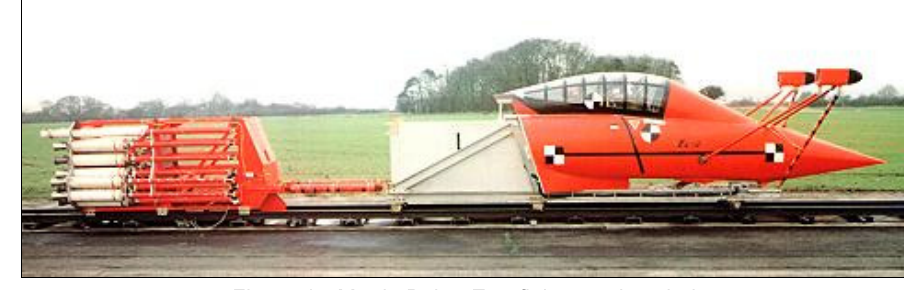
Рис . 4 – Ракетные сани Мартин Бейкер для моделирования разгона самолета Eurofighter Слика 4 – Ракетне санке Martin Baker за симулацију убрзања на авиону